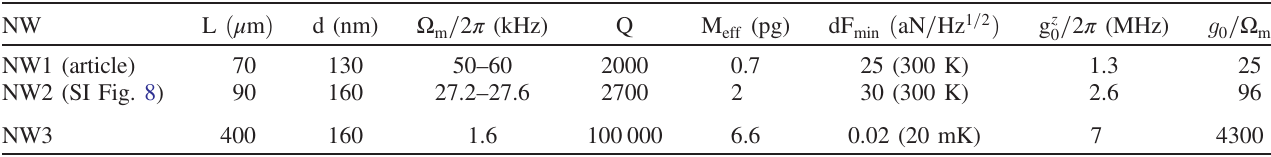
TABLE I. Nanowires discussed in this work. NW1 and NW2 were tested at room temperature in the cavity. NW3 is an estimation based on the typical nanowires investigated at dilution temperatures [60] with a 10 - μ m cavity length. NW L ð μ m Þ d (nm) Ω